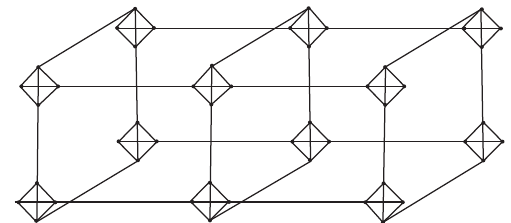
Figure 2: The hierarchical hypercube network ( HHC − 2 )